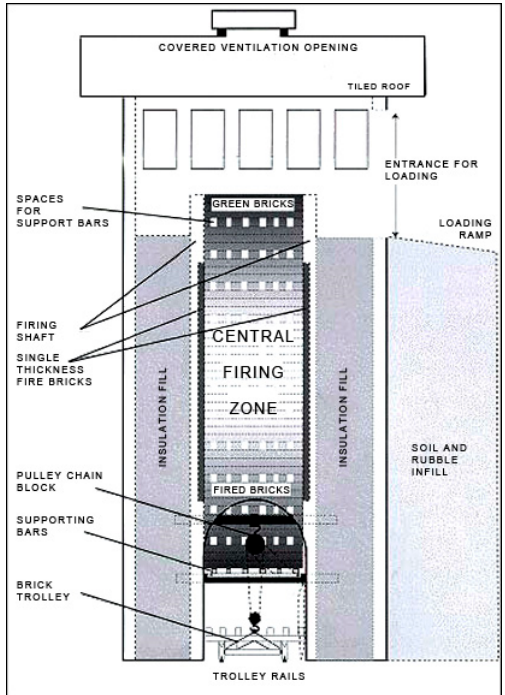
Figure 1. Modern vertical shaft brick kiln (VSBK) kiln schematic diagram [26].